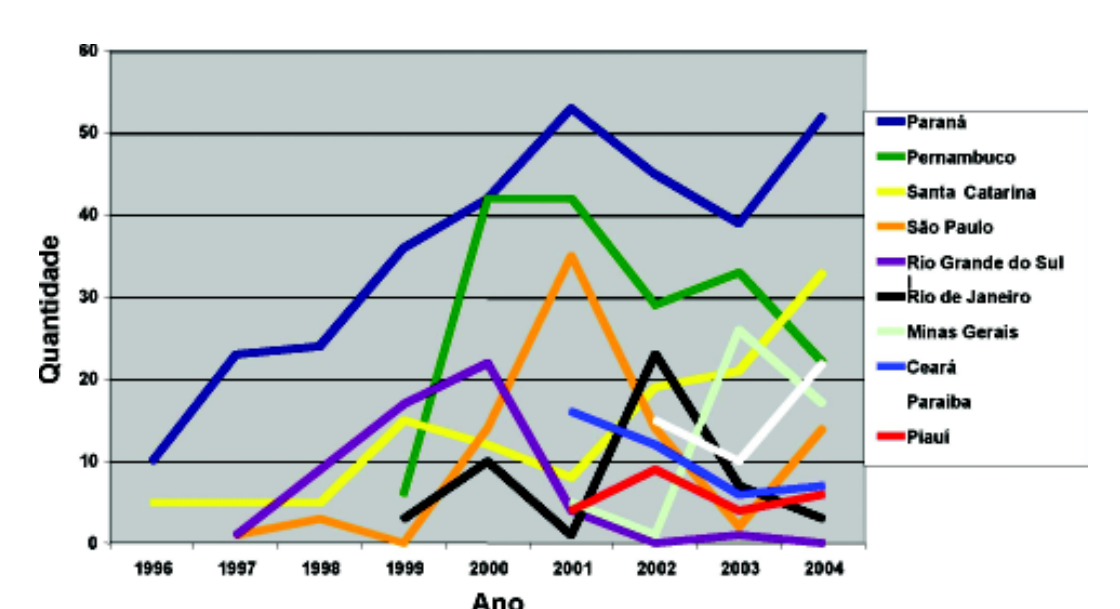
Fig. 3 - Corações recebidos no BVCHSC, estratificados por